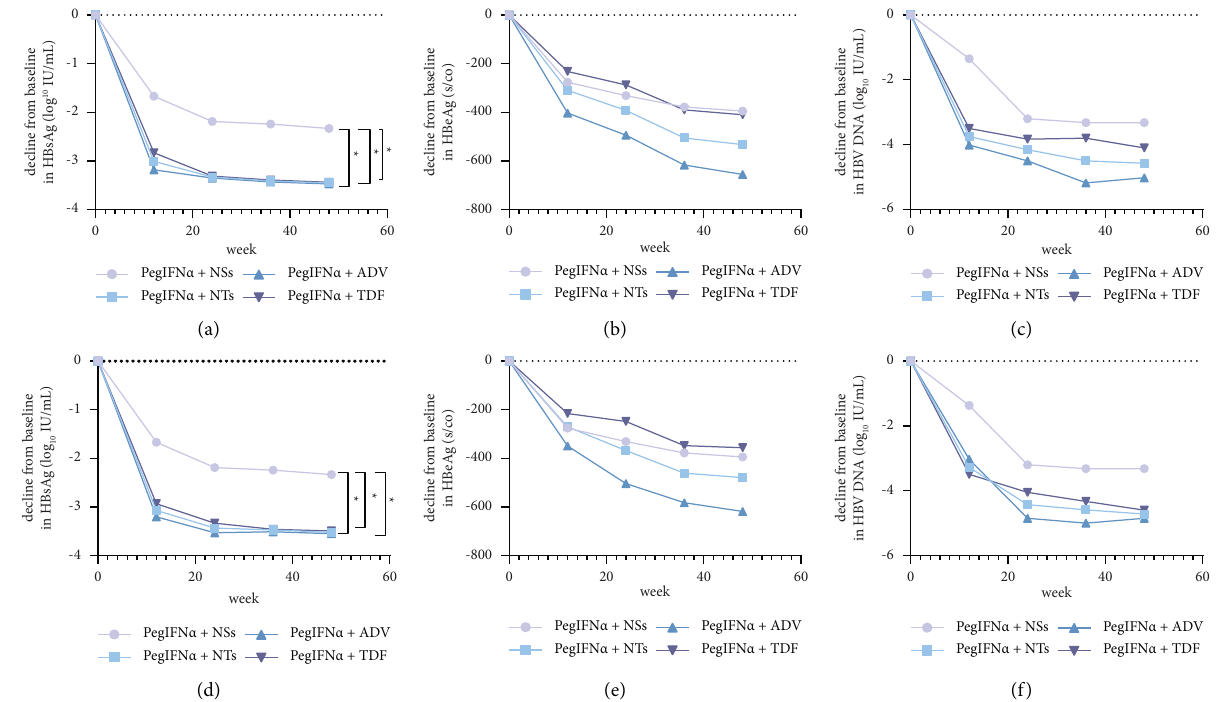
Figure 2: Mean reductions from baseline in diferent indicators. (a) HBsAg decline before matching; (b) HBeAg decline before matching; (c) HBV DNA decline before matching; (d) HBsAg decline after matching; (e) HBeAg decline after matching; (f) HBV DNA decline after matching. ∗ P < 0 .